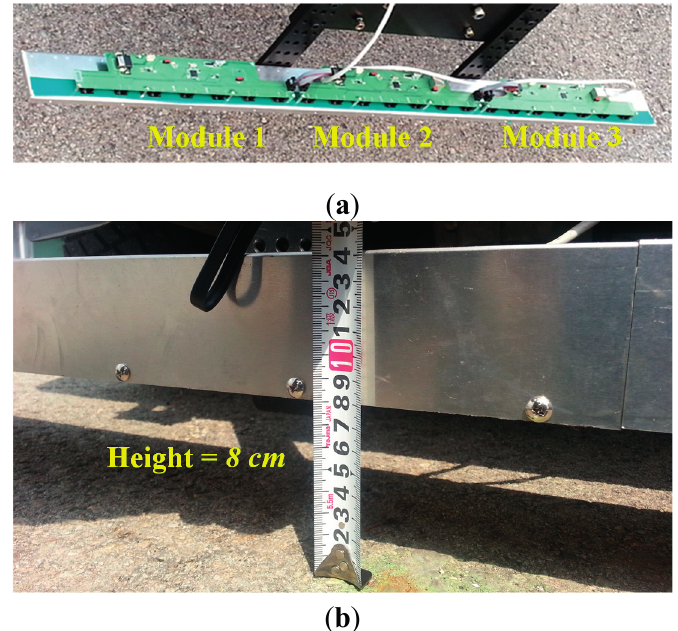
Figure 4. Fabrication and installation of magnetic sensing array: ( a ) Assembly of three modular boards; ( b ) MSR mounted on the